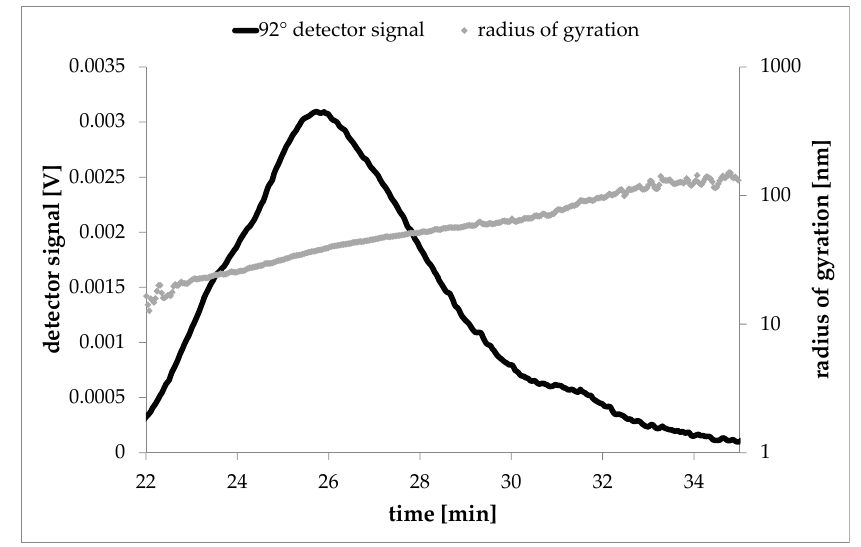
Figure 4. Elugram of an AF4 run with laponite particles (2000 ng/mL, 2000 µL injected. Signal of the 92° detector overlaid with the calculated radii of gyration at the relevant elution times.